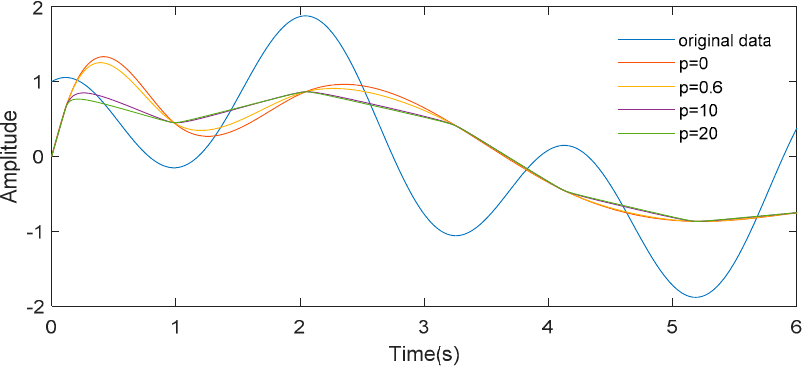
Figure 4. Local mean curves corresponding to different values of the pole parameter p